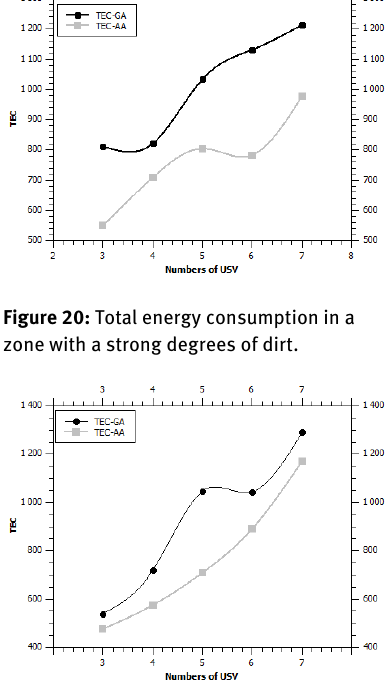
Figure 22: Displacement – cleaning en- ergy consumption in a zone with a low degrees of dirt.